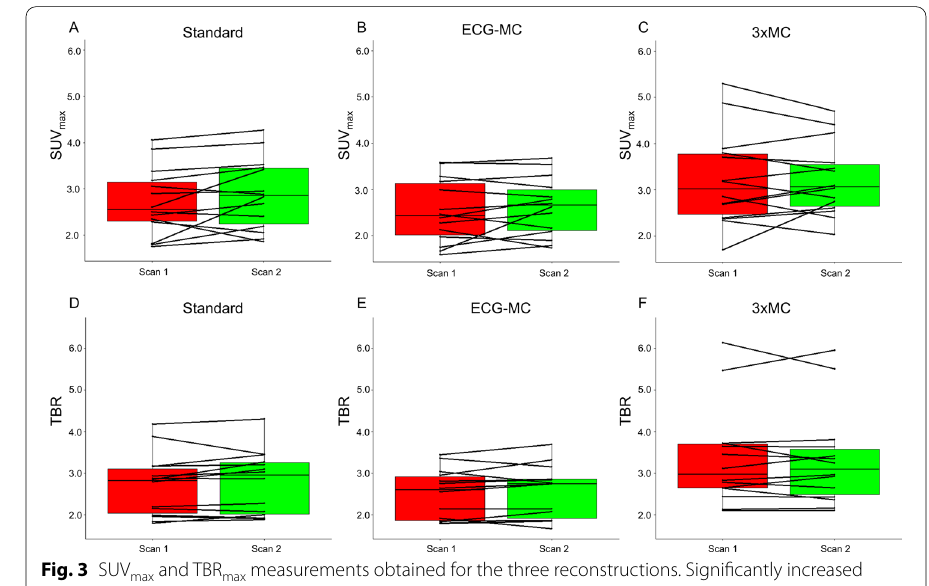
MC datasets when compared to standard and × end-diastolic imaging, ECG-MC = maximum standard uptake value, =